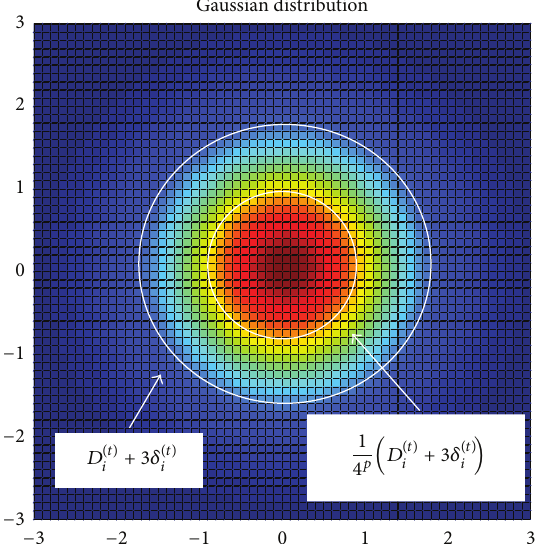
Figure 1: The illustration of compact central region of a class. In a class 𝑅 (𝑡) 𝑖 , most of points cluster around their centroid and few points are far away from the centroid. Subset 𝐾 (𝑡) 𝑖 (i.e., the shadow part) is the central region of class 𝑅 (𝑡) 𝑖 . Compact set is the set where many points cluster in a small region tightly. Increasing parameter 𝑝 will shorten radius and make 𝐾 (𝑡) 𝑖